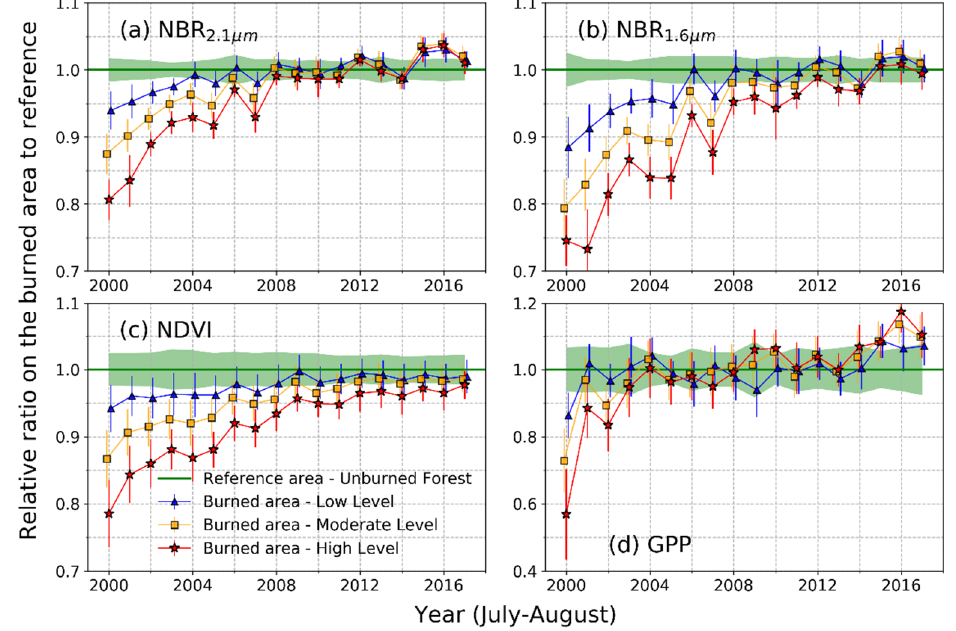
Figure 6. Relative change in vegetation indices and GPP in the burned area compared with the reference area. Green lines indicate average value and green shadings indicate confidence intervals in the unburned forest area. Lines and error bar for blue triangles, yellow squares, and red stars indicate average values and confidence intervals in the low, moderate, and high severity burned areas, respectively: ( a ) NBR 2.1 ; ( b ) NBR 1.6 ; ( c ) NDVI; and ( d )